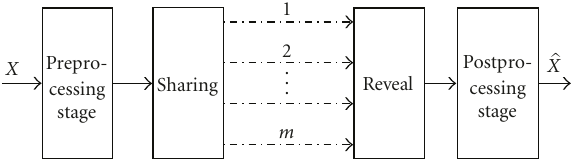
Figure 1: The block diagram of the proposed method.